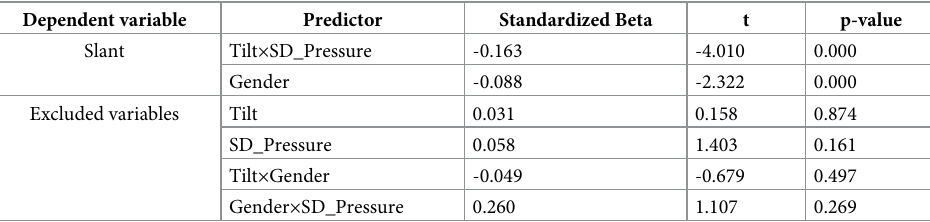
Table 9. Revised regression model of students’ Chinese handwriting slant degree and other features.